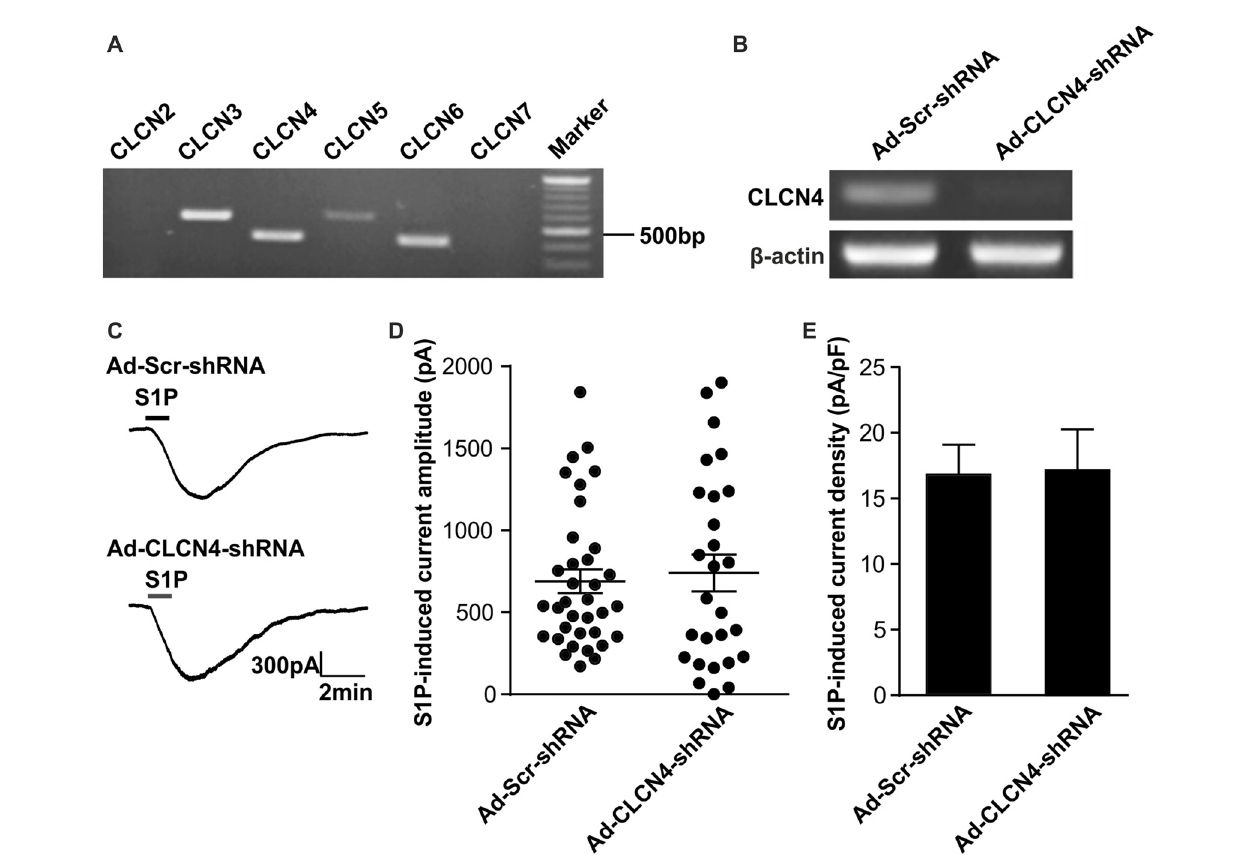
FIGURE 1 | Down-regulation of Clcn4 mRNA does not alter S1P-induced Cl − current in sensory neurons. (A) Expression of chloride channels in mouse dorsal root ganglia (DRG). Representative RT-PCR results for Clcn2 , Clcn3 , Clcn4 , Clcn5 , Clcn6 and Clcn7 mRNA in intact DRG. Marker: 100bp DNA ladder. (B) Cultured DRG neurons were infected with scrambled shRNA adenovirus (Ad-Scr-shRNA) or adenovirus encoding specific shRNA against CLCN4 (Ad-CLCN4-shRNA). Representative RT-PCR results from three independent experiments showed that Clcn4 mRNA level was reduced 3 days after infection by CLCN4 shRNA adenovirus but not with scrambled shRNA adenovirus. (C) Example traces of excitatory inward currents (carried by Cl − efflux) induced by 1 µ M S1P recorded in DRG neurons infected with scrambled shRNA adenovirus or CLCN4 shRNA adenovirus at − 60 mV holding potential. (D) Dot-plot depicting the amplitude